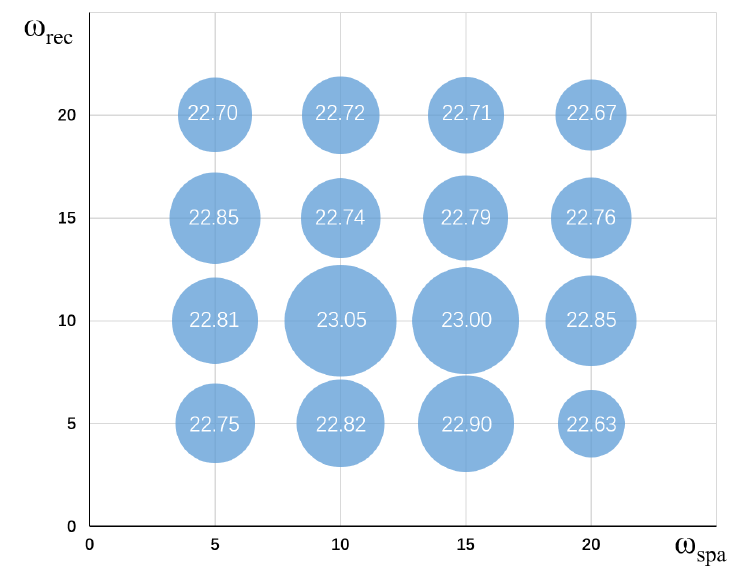
Figure 4. The PSNR values corresponding to the varying weights of the spatial consistency loss and reconstruction loss. The x and y axes respectively represent w spa and w rec , with the number in a bubble being the PSNR value (dB), whose magnitudes are positively correlated with the square size of its